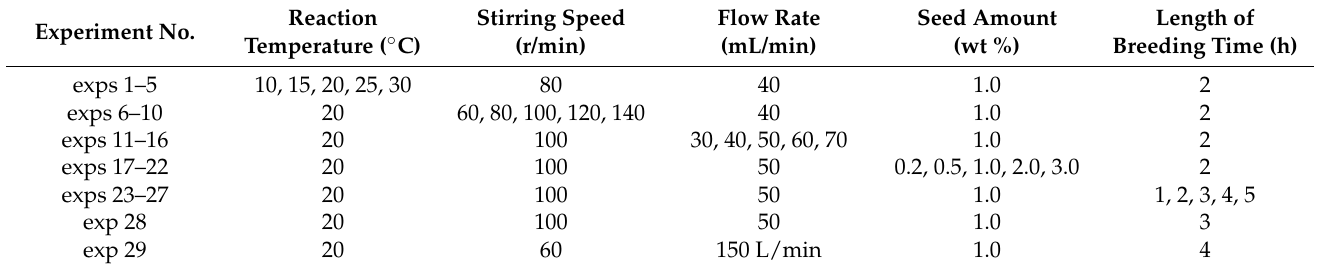
Table 2. Experiments.